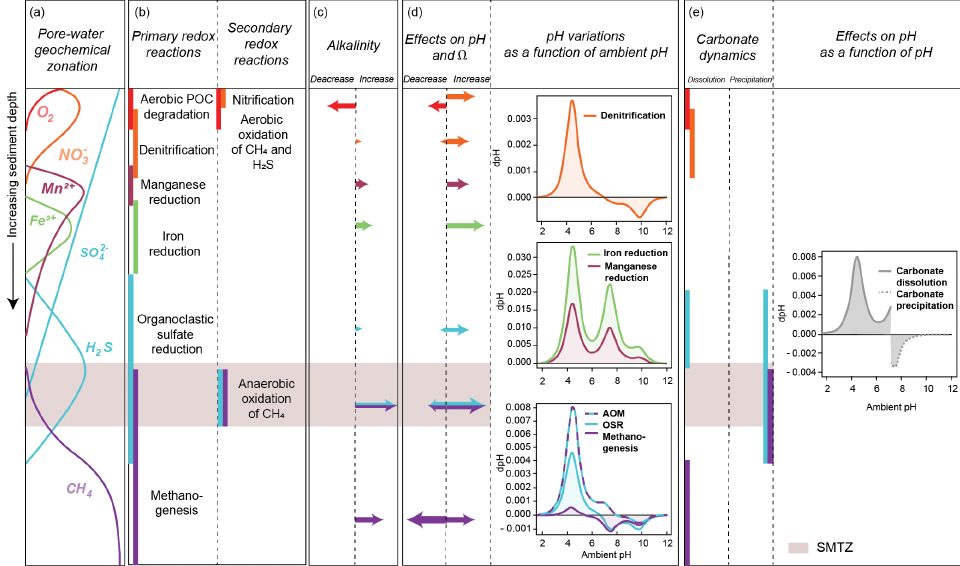
Figure 8. Idealised profile showing depth distribution of ( a ) pore-water geochemical zonation, ( b ) main primary and secondary redox reactions occurrence, ( c ) alkalinity fluxes, ( d ) pore-water pH/carbonate saturation state ( Ω ), and ( e ) carbonate precipitation/dissolution occurrence. Note that the secondary columns ( d , e ) show the distinct effect of the different chemical processes presented on pH changes ( dpH ) as a function of ambient pH. The sign change in some of these highly non- linear functions denotes that the direction and magnitude of pH change according to the initial pH conditions. Sizes of the arrows in columns ( c , d ) are qualitative indicators of the magnitude of the effect of each biogeochemical path on alkalinity, pH, and Ω . OSR: organoclastic sulfate reduction; AOM: Anaerobic oxidation or methane; DOC: dissolved organic carbon; DIC: dissolved inorganic carbon. Table 2. Main secondary reactions impacting on pore-water alkalinity, pH and oxygen concentration in methane-rich marine sediments. NH + : Ammonium, O 2 : Oxygen, HCO − : Bicarbonate, NO − : 3 3 4 Nitrate, CO 2 : Carbon dioxide, H 2 O : Water, H 2 S : Hydrogen sulfide, SO 2 − : Sulfate, CH 4 : 4